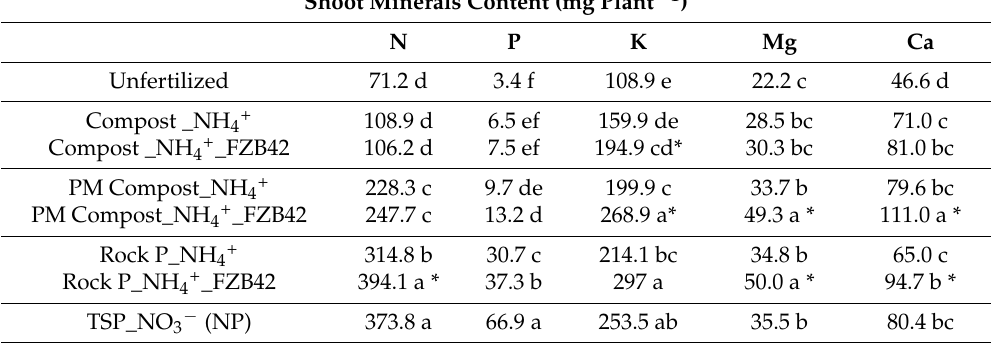
Table 3. Effects of Bacillus amyloliquefaciens FZB 42 inoculation on shoot accumulation of N, P, K, Mg, and Ca of 5-week-old tomatoes on pH 5.6 soil supplied with different fertilizers. (Compost_NH 4 = municipal waste compost + stabilized ammonium sulfate, PM-Compost_NH 4 = municipal waste compost + poultry manure + stabilized ammonium sulfate, Rock P_NH 4 = rock phosphate + stabilized ammonium sulfate, NP = calcium nitrate plus superphosphate). Means and SE of four replicates. Significant treatment differences are indicated by different letters (T-grouping (LSD) at p = 0.05). * = significant difference compared with the non-inoculated control (NoBE) within the same fertilizer treatment ( t -test at p <